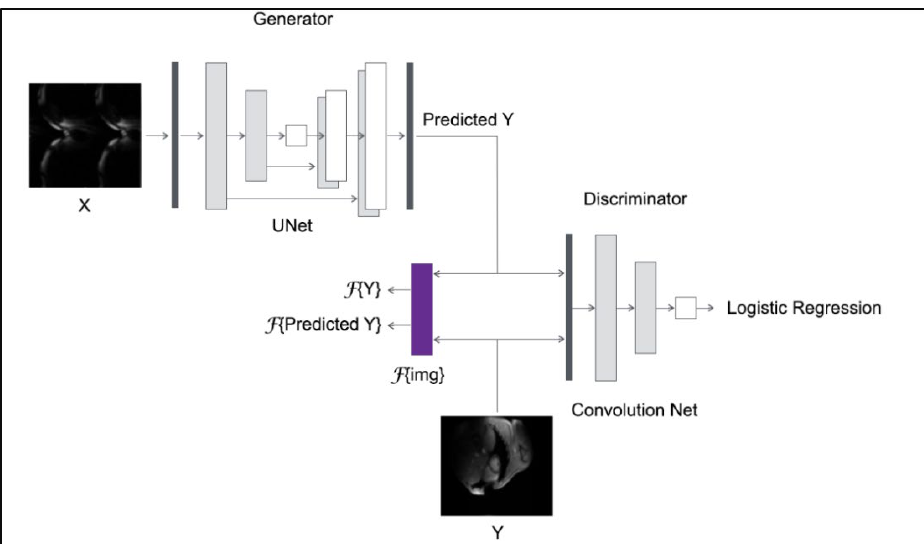
Figure 5. The training strategy for the CAGN model with Fourier loss.